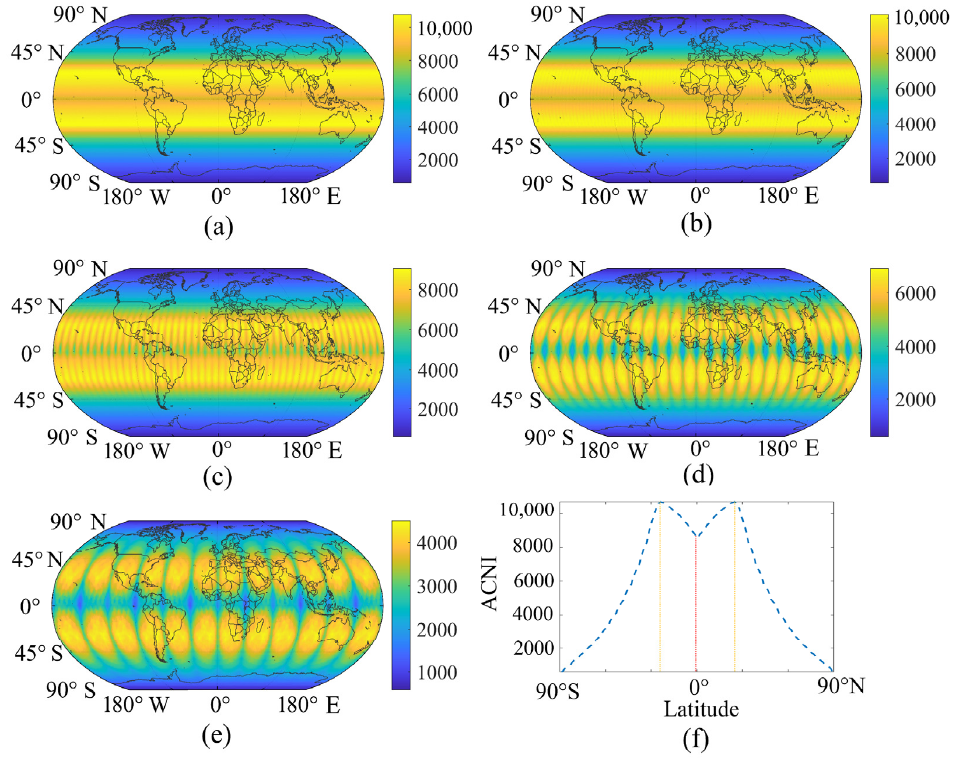
Figure 7. Global angular combination number index (ACNI) maps at time sampling intervals of ( a )